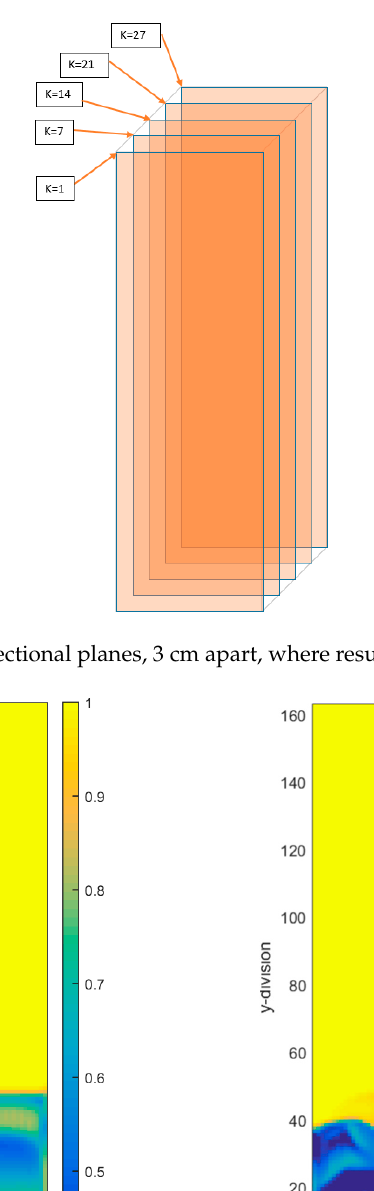
Figure 10. Cross-sectional planes, 3 cm apart, where results are presented.